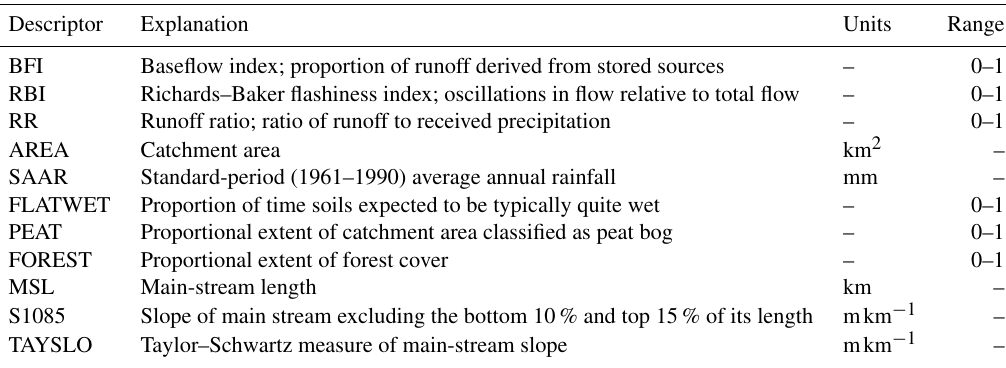
Table 1. Physical catchment descriptors referred to in this